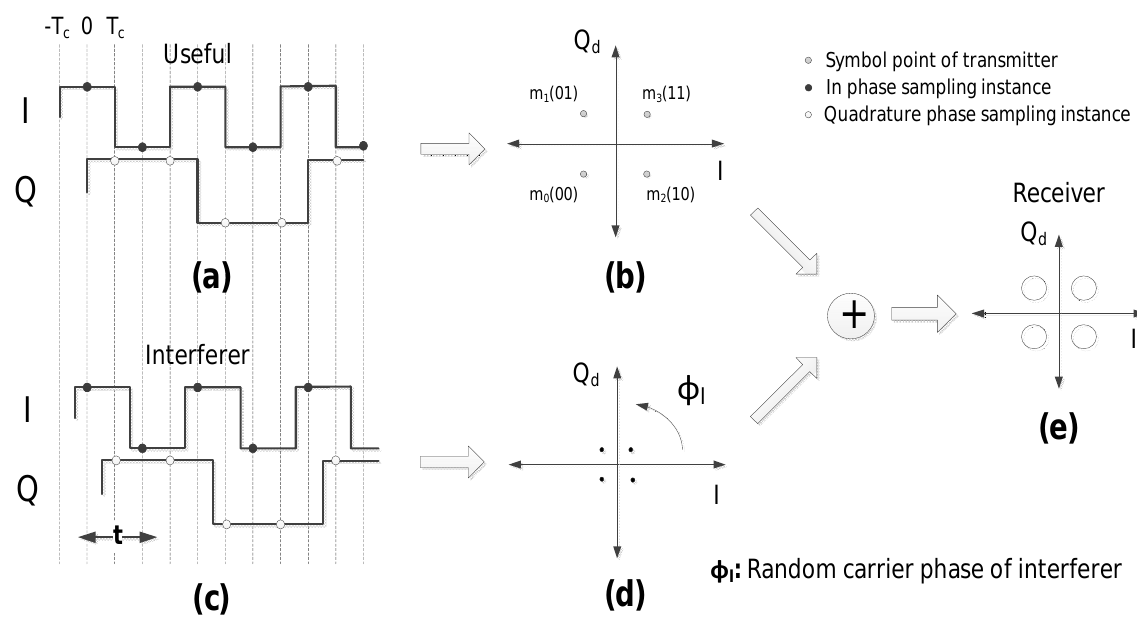
Figure 1. The impact of the interferer. ( a ) Useful signal; ( b ) Q of useful signal; ( c ) Interferer signal; ( d ) Q ( e ) Q -I domain representation of received d